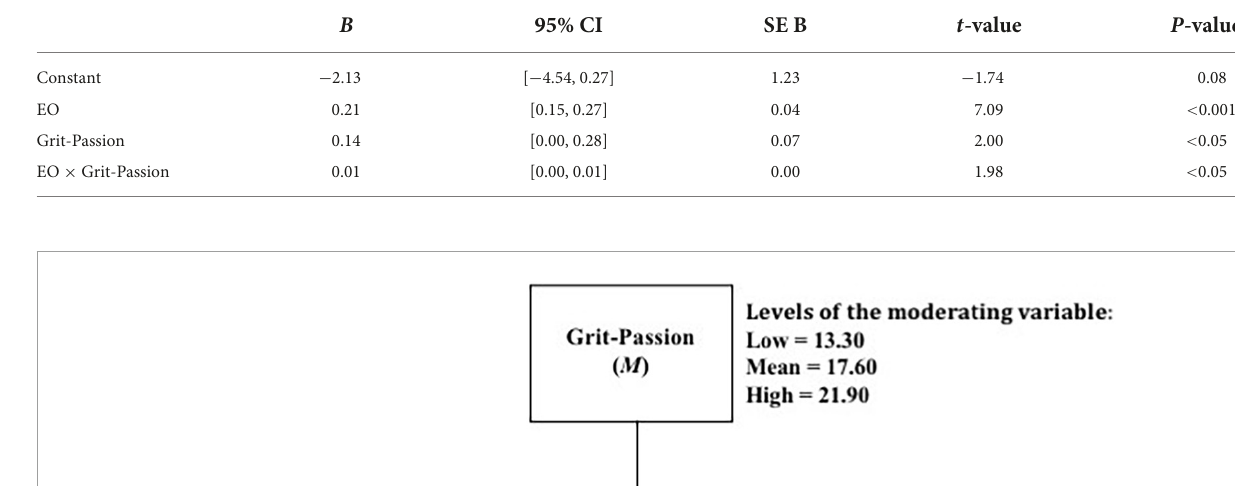
TABLE 4 Linear model of predictors of PSB, considering Grit-Passion ( R 2 = 26.11%, p < 0.001).